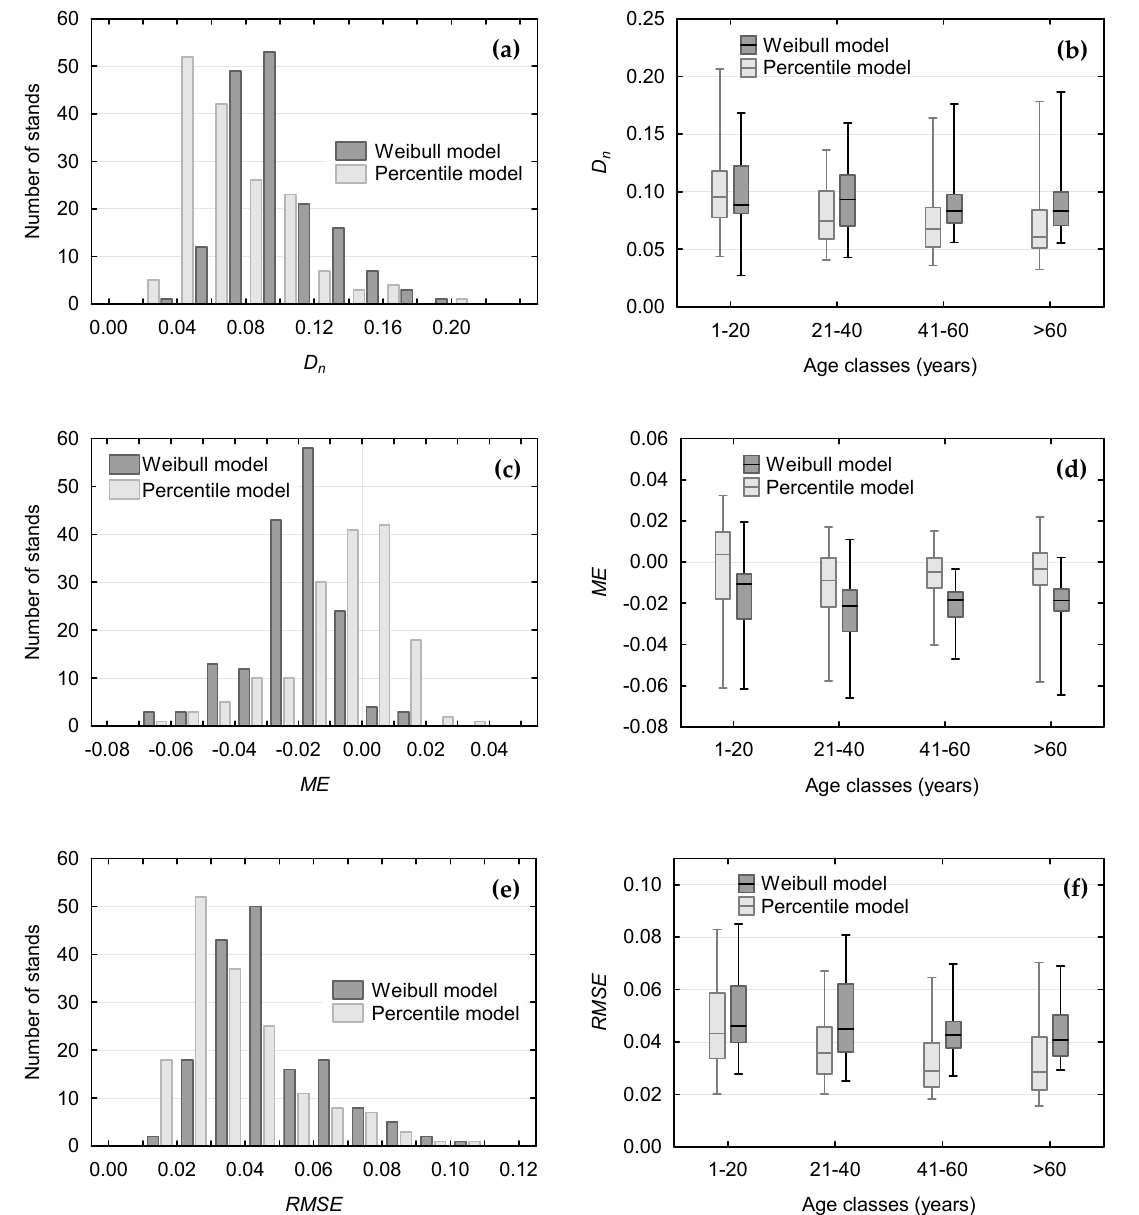
Figure 4. Distributions of goodness-of-fit statistics: ( a , b ) Kolmogorov–Smirnov D n statistic, ( c , d ) mean error (ME) , ( e , f ) root mean squared error (RMSE) for the fitted Weibull and percentile models in black alder stands.